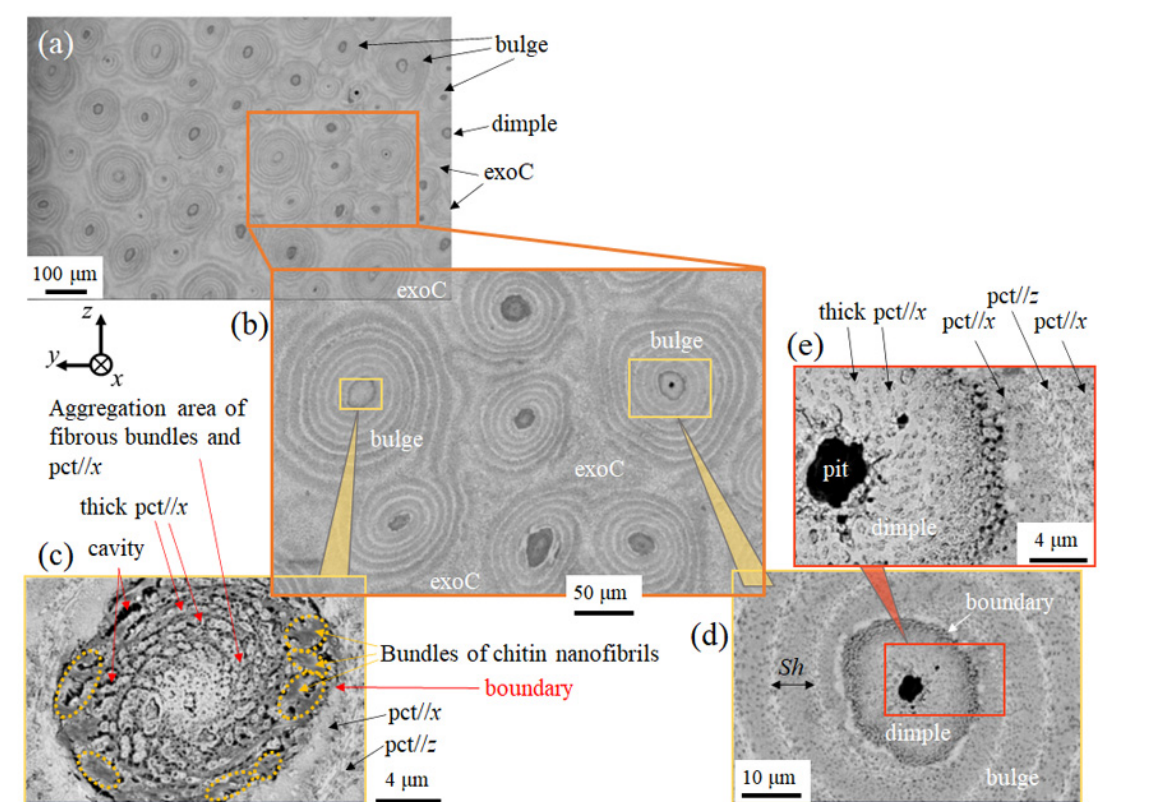
Figure 6. SEM images of a transverse section through the exocuticle layer on the mottled, deep-blue exoskeleton: ( a ) wide area including many bulges, ( b ) enlarged view of the area surrounded by rectangle in ( a ), ( c ) enlarged view of the bulge top surrounded by a rectangle in ( b ), ( d ) enlarged views of the bulge top with the pit surrounded by a rectangle in ( b ), and ( e ) enlarged view surrounded by a rectangle in ( d ). Here, Sh denotes the stacking height of the twisted plywood structure. Figure 7 shows EDS maps for the region shown in Figure 6b. There was almost no calcium (Ca) in the dimple; conversely, the amounts of phosphorus (P) and magnesium (Mg) were high. In short, the dimple seen in the center of the bulge is a canal tube formed by organic matter in which thick pcts// x connected to cells are gathered. These tubes pen- etrate the exoskeleton surface (Figure 4b–d), appearing as white streaks on the fracture surface (Figure 4b,d) and as black or white streaks on the polishing surface (Figure 2). The clear appearance of the dimple with increased drying time shown in Figures 4 and 5 is due to shrinkage, which depends on the drying of the organic matter.